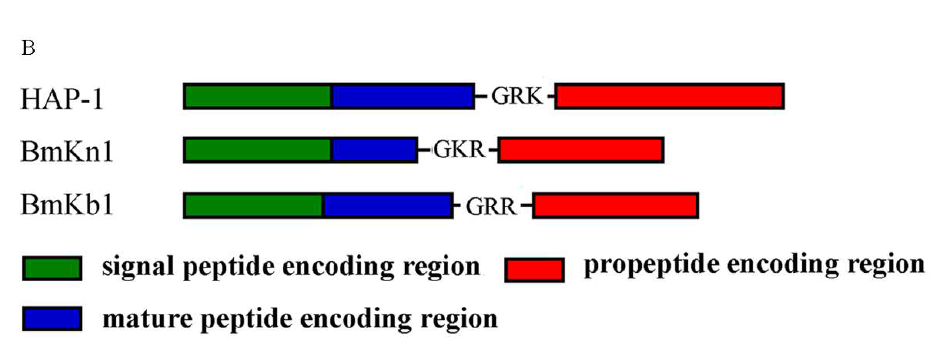
Figure 1. Precursor of HAP-1. ( A ) The cDNA and protein sequences of HAP-1. The deduced amino acid residues are given below the corresponding nucleotide codons. The amino acid residues sequence is numbered starting from the N-terminal residue of the peptide; the first residue of the mature peptide is numbered as +1, whereas the signal peptide is numbered as minus. The signal peptide is underlined; a putative polyadenylation signal ( AATAAA ) is marked by italic; the posttranslational processing signal is marked with a box. ( B ) Comparison of the precursor structure of HAP-1 with those of some antimicrobial peptides from the scorpion M. martensii Karsch.